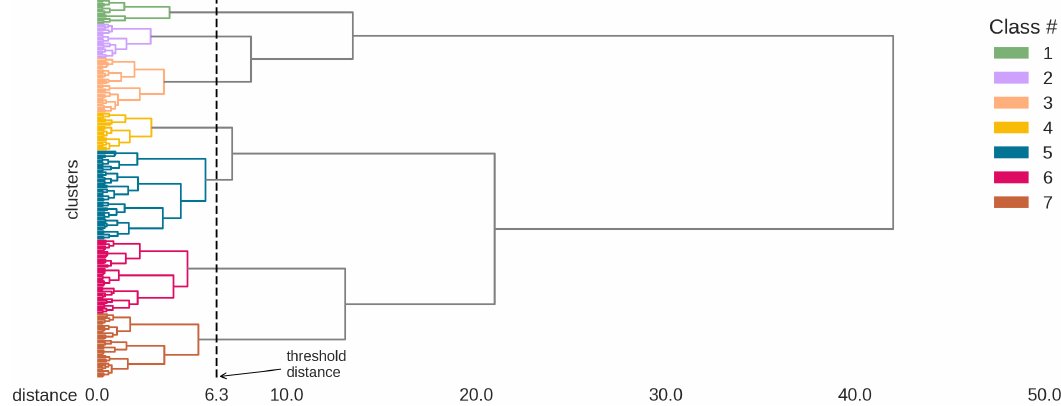
Figure 7. Dendrogram of hierarchical clustering of the geometric features of defects. The threshold distance d t is marked by a dotted line.